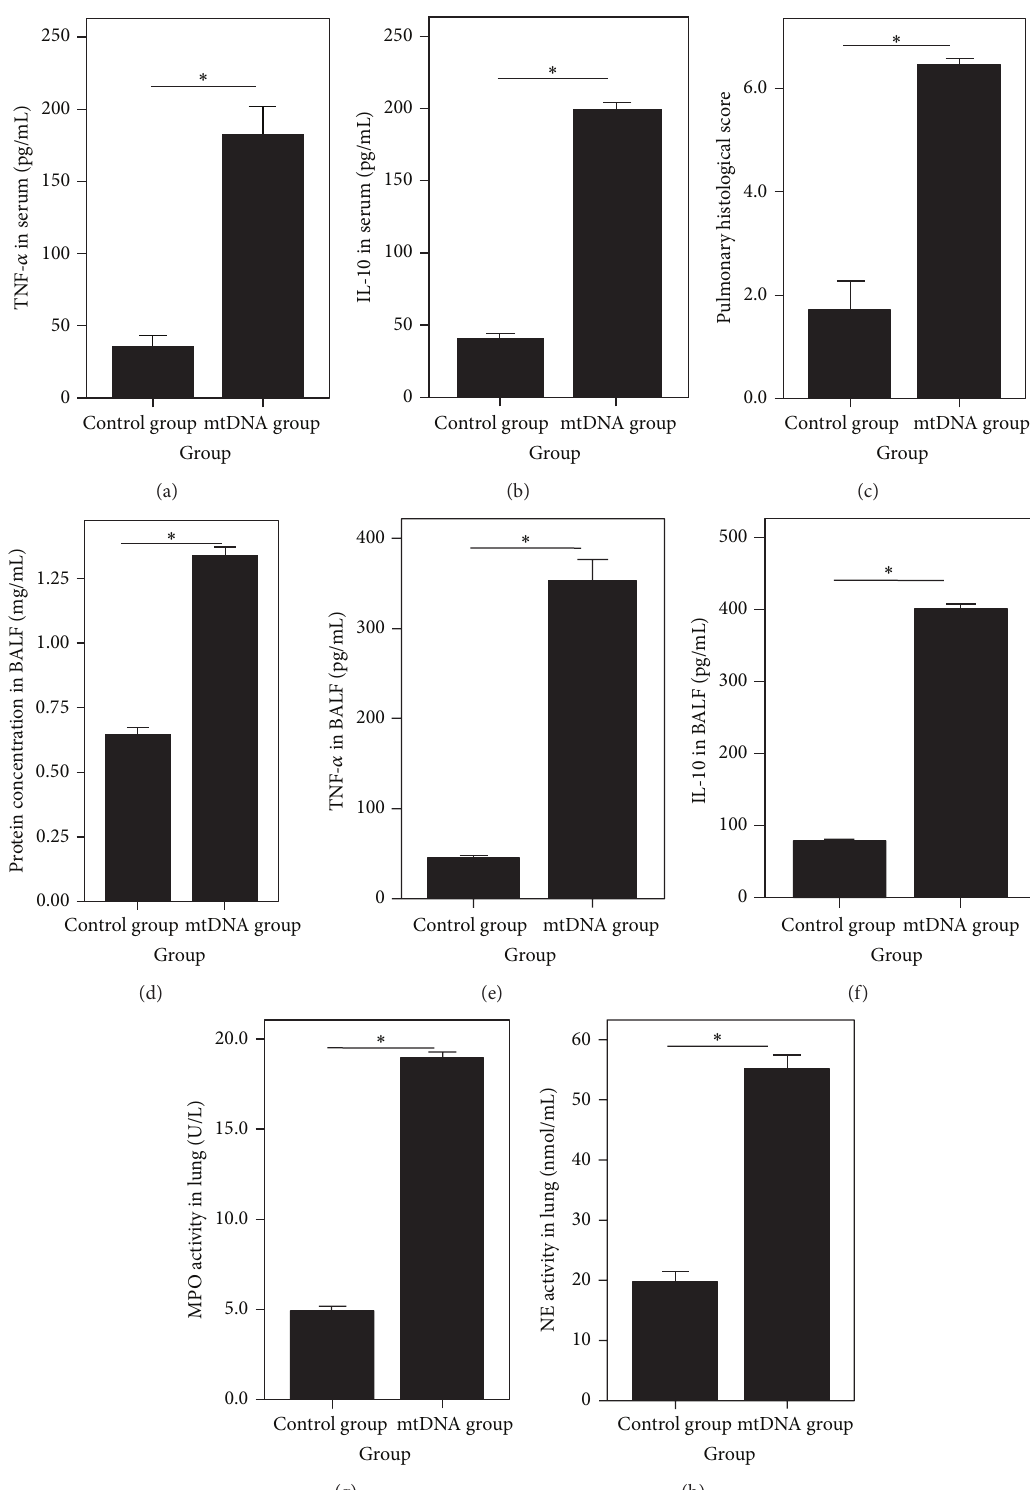
Figure 7: The serum TNF- 𝛼 (a) and IL-10 (b) levels, the pulmonary histological score (c), the protein (d), TNF- 𝛼 (e) and IL-10 (f) concentrations in BALF, and the lung tissue MPO (g) and NE (h) activity. Results are expressed as mean ± standard error. ∗ 𝑃 < 0.05 when compared to other